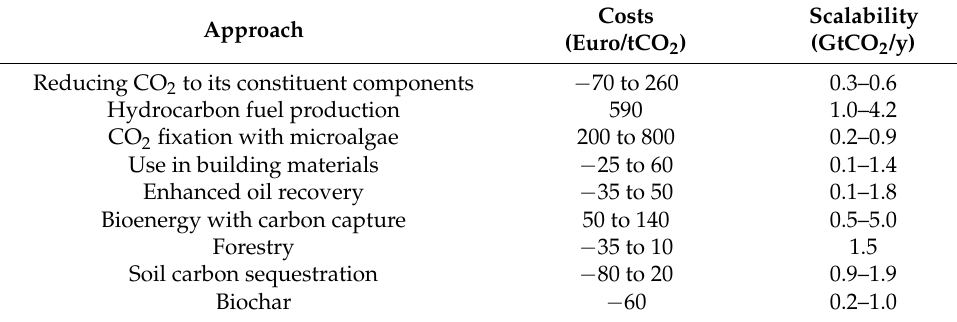
Table 4. Comparison of methods for CO 2 reduction. Costs and scalability